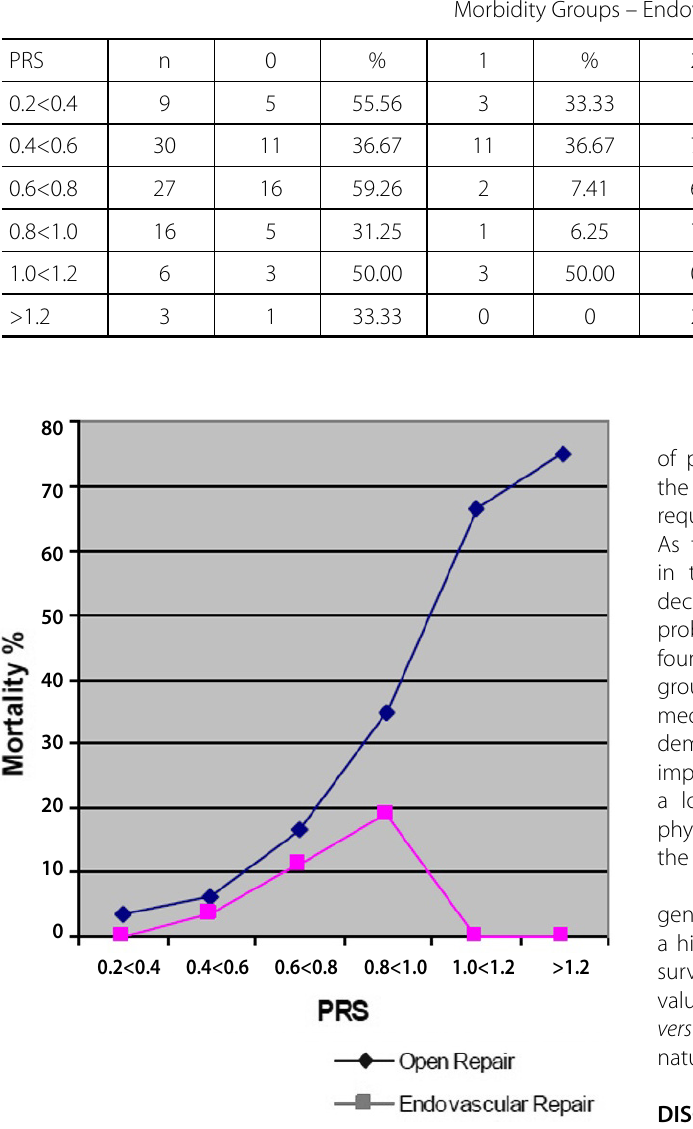
Fig. 2 - Surgical mortality in the OR and EVAR groups according to